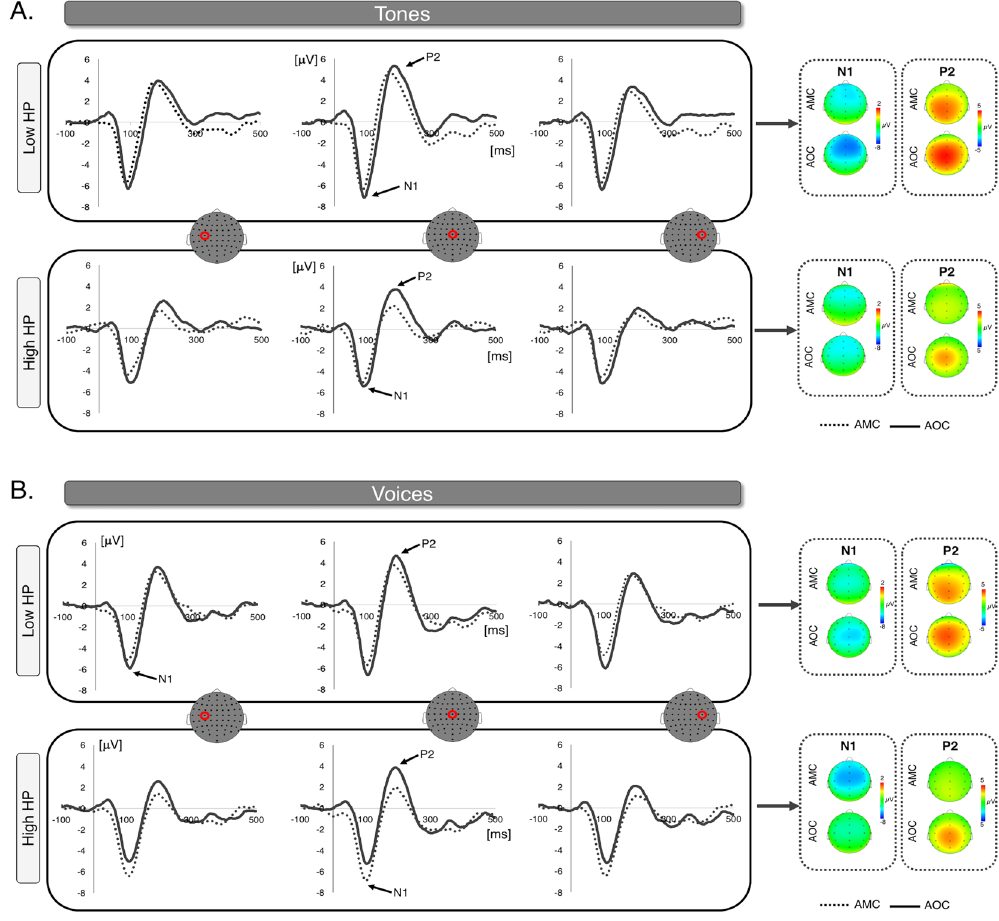
Figure 2. Grand average waveforms contrasting self-triggered and externally triggered tones (Panel A) and self- voices (Panel B) at electrodes C3, Cz and C4. A median split was performed on the data to illustrate differences in the processing of self- and externally triggered stimuli as a function of HP (high HP: ≥ 26, N = 17, range LSHS Total : 26–51; low HP: < 26, N = 15, range LSHS Total : 0–25). Topographic maps show voltage distribution in the 80–120 ms (N1) and 175–215 ms (P2) time windows. Notes: HP = hallucination predisposition; AMC = auditory-motor condition; AOC = auditory-only